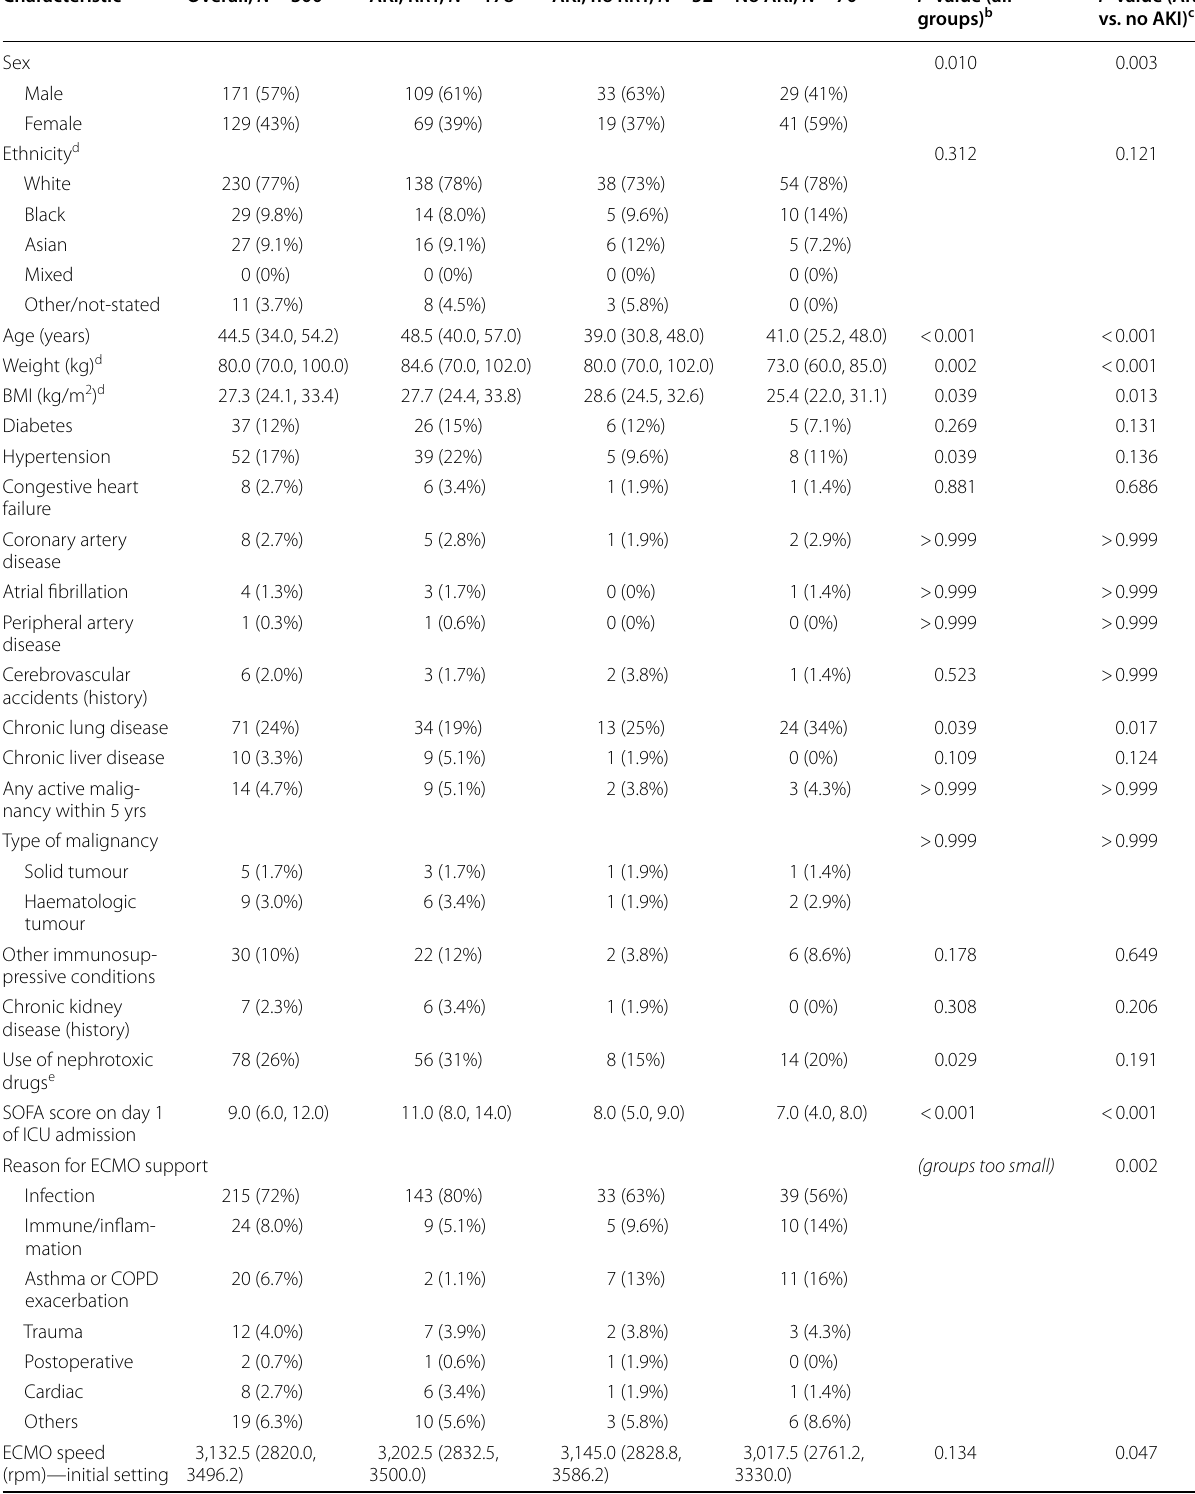
Table 1 Baseline characteristics of patients by AKI and RRT